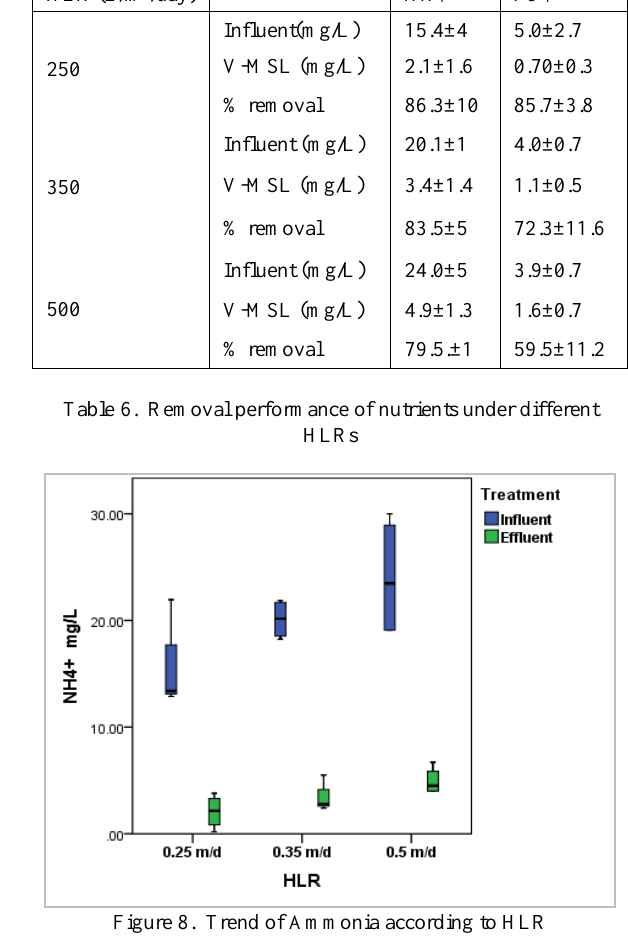
Figure 8. Trend of Ammonia according to HLR